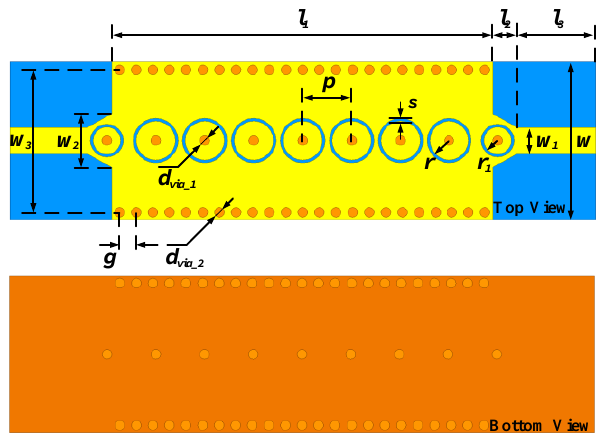
Figure 3. Schematic configuration of the BPF using the proposed SSPP. Table 1. Parameters of BPF Using the Proposed SSPP.